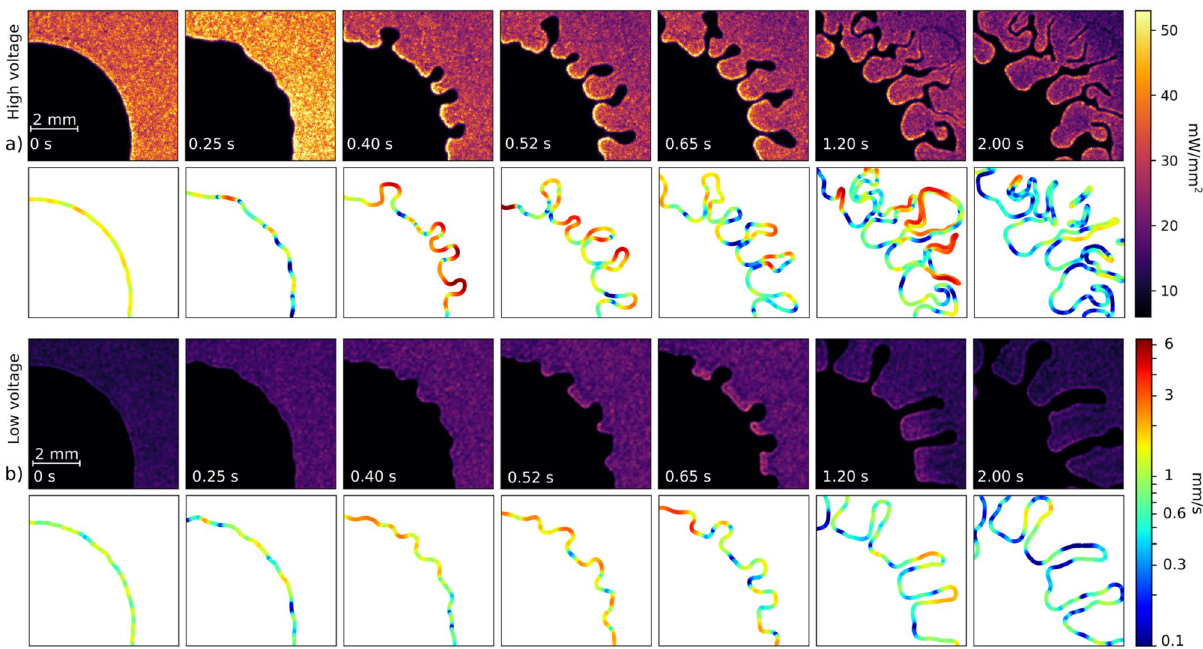
Figure 3. Simultaneous visualisation of the two-dimensional development of the local dissipated power density (first and third row, upper scale bar) and velocity field (second and fourth row, lower scale bar) at the interface for ( a ) high (7.8 kV) and ( b ) low (5 kV) voltage scenarios. The scales for power density and velocity are common for both voltage scenarios.